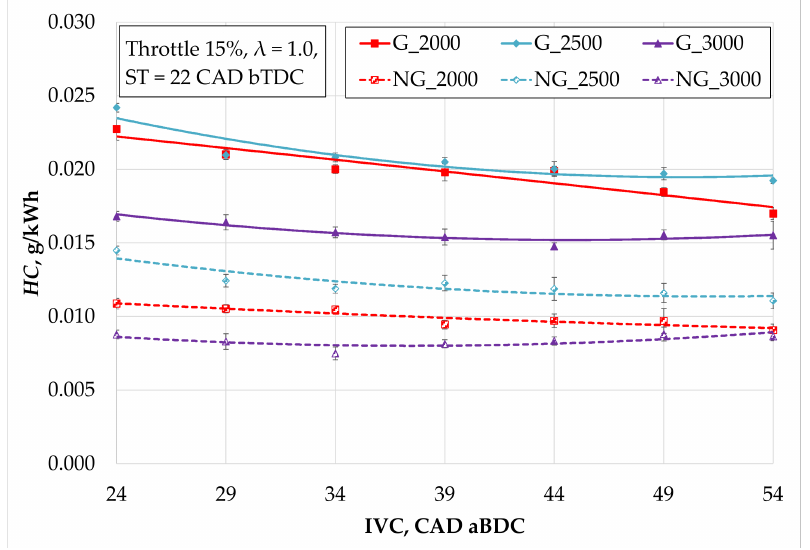
Figure 15. Change of the specific HC emissions from an engine running on gasoline and natural gas and while changing the intake valve close